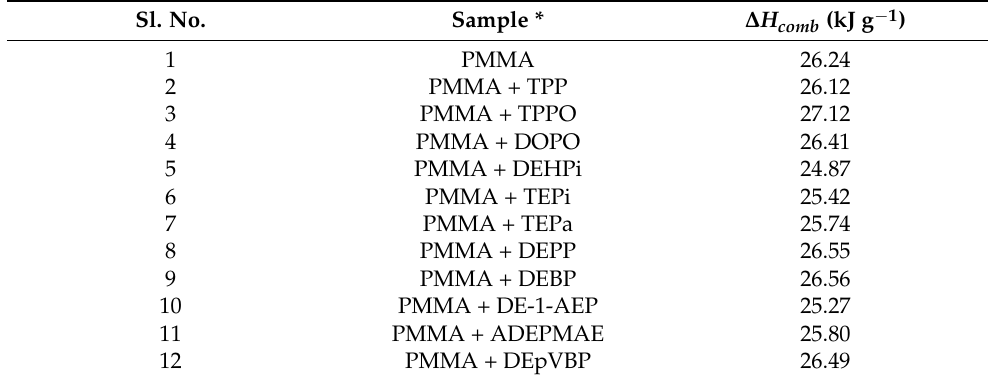
Table 7. Heat of combustion data for PMMA-based samples from ‘bomb’ calorimetric measurements. Sl.